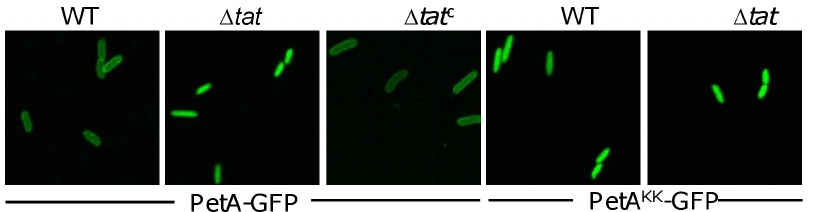
Figure 5. PetA is a Tat substrate in S.oneidensis . Fluorescence images of the wild type strain, D tat and its complemented strains carrying IPTG- inducible plasmid expressing hybrid protein PetA-GFP or PetA KK -GFP. Cells at exponential phase ( , 0.4 of OD 600 ) were induced by 0.1 mM IPTG for 2 hours, and then sampled and visualized under a Zeiss LSM-510 confocal laser scanning microscope. The images were taken 1 h after the end of